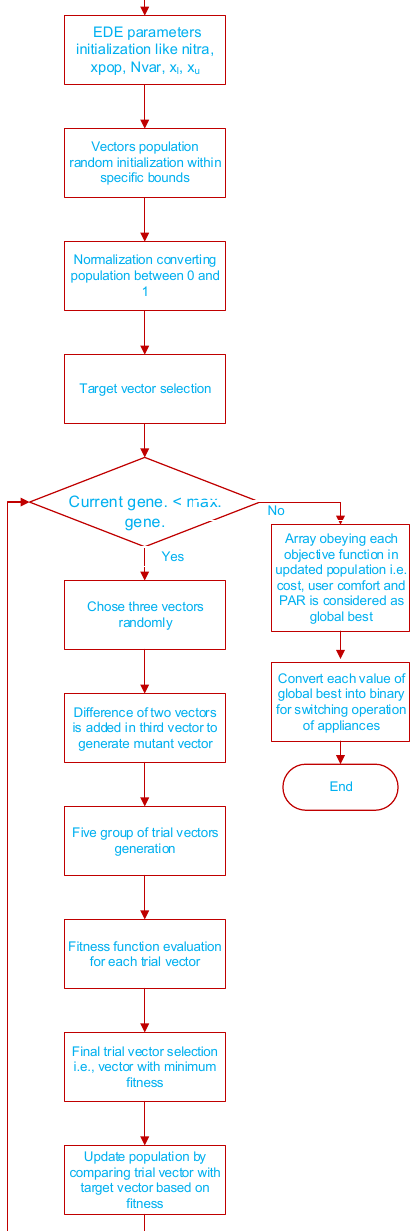
Figure 6. EDE implementation